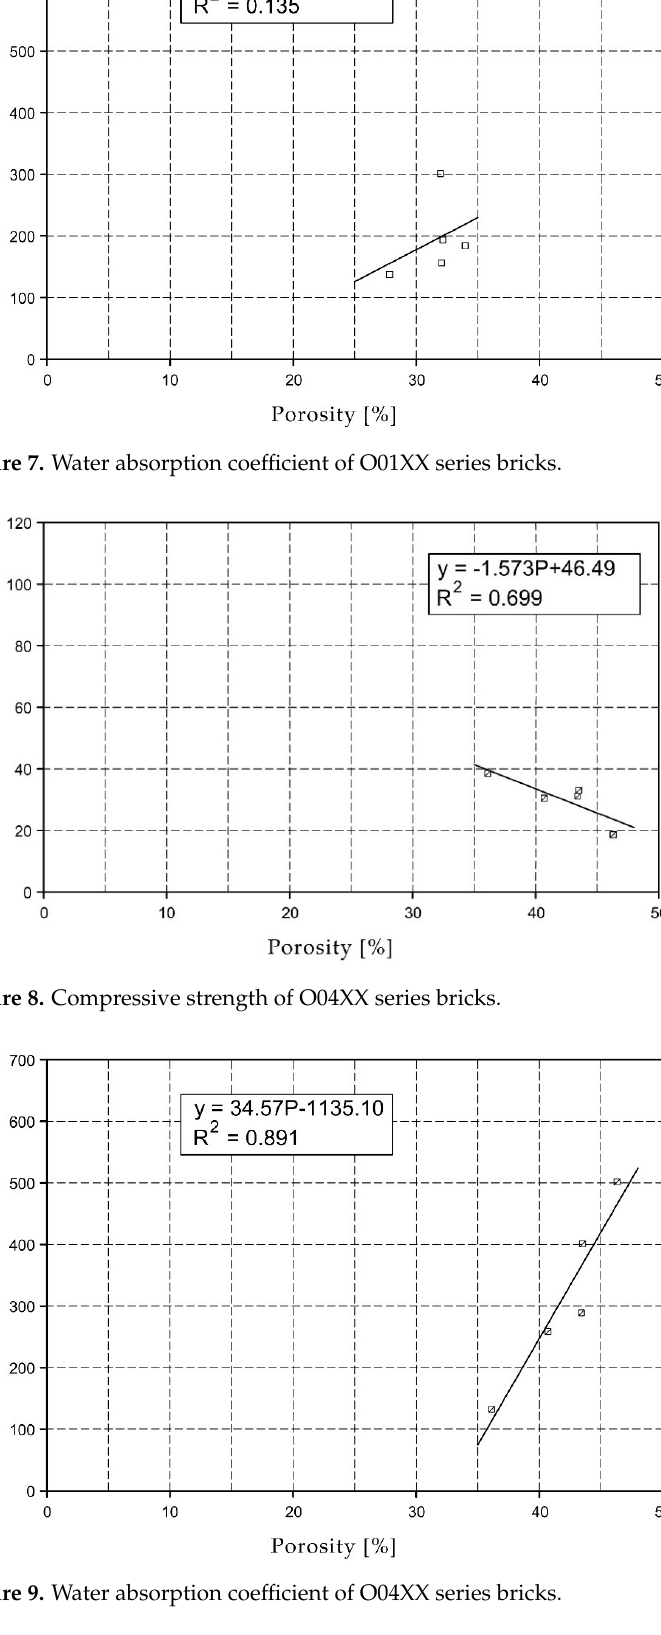
Figure 9. Water absorption coefficient of O04XX series bricks.